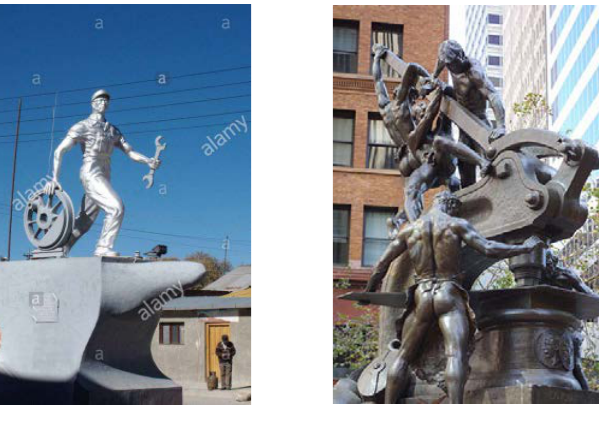
Fig 5 A rail-worker statue, Bolivia, South Fig 6 the MECHANICS monument, by the artist America Douglas Tilden, San Francisco,